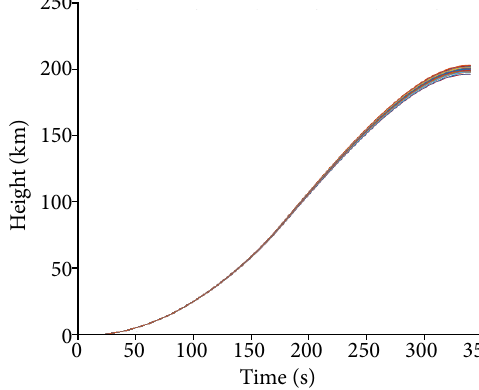
Figure 8. Reducing the effect of uncertainties on SLV height with robust optimal design.